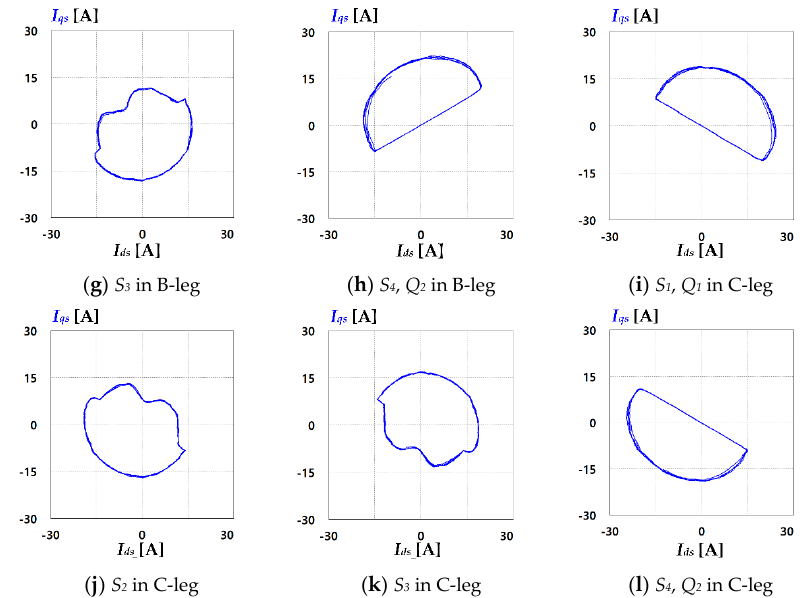
Figure 8. Current patterns according to different faulty condition (healthy condition: r = 15 A).